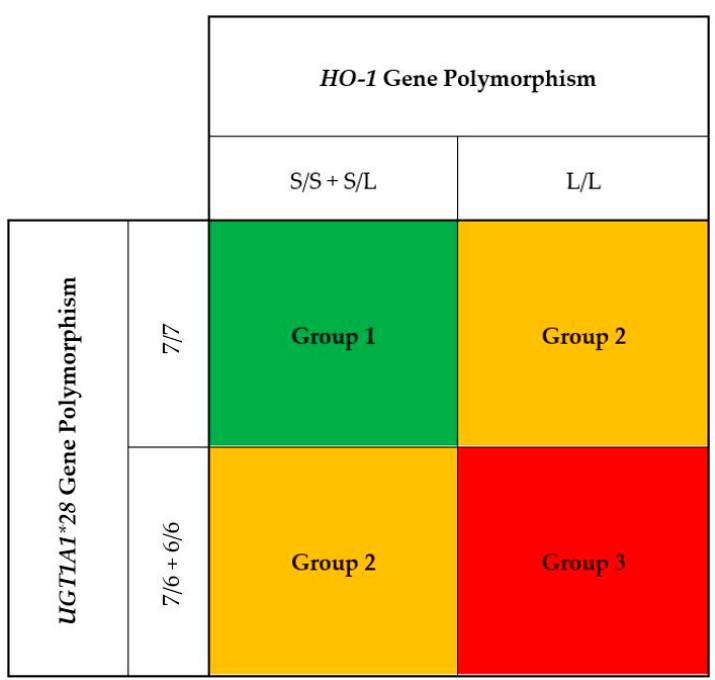
Figure 1. A total of 1080 hemodialysis patients were classified into three groups by the combina- tion of three genotypes of the HO-1 gene promoter (S/S, S/L, and L/L) with three genotypes of the UGT1A1 gene (7/7, 7/6, and 6/6). We constructed three genetic models including S/S + S/L with 7/7 (Group 1); L/L with 7/7 and S/S + S/L with 7/6 + 6/6 (Group 2); and L/L with 7/6 + 6/6 (Group 3).